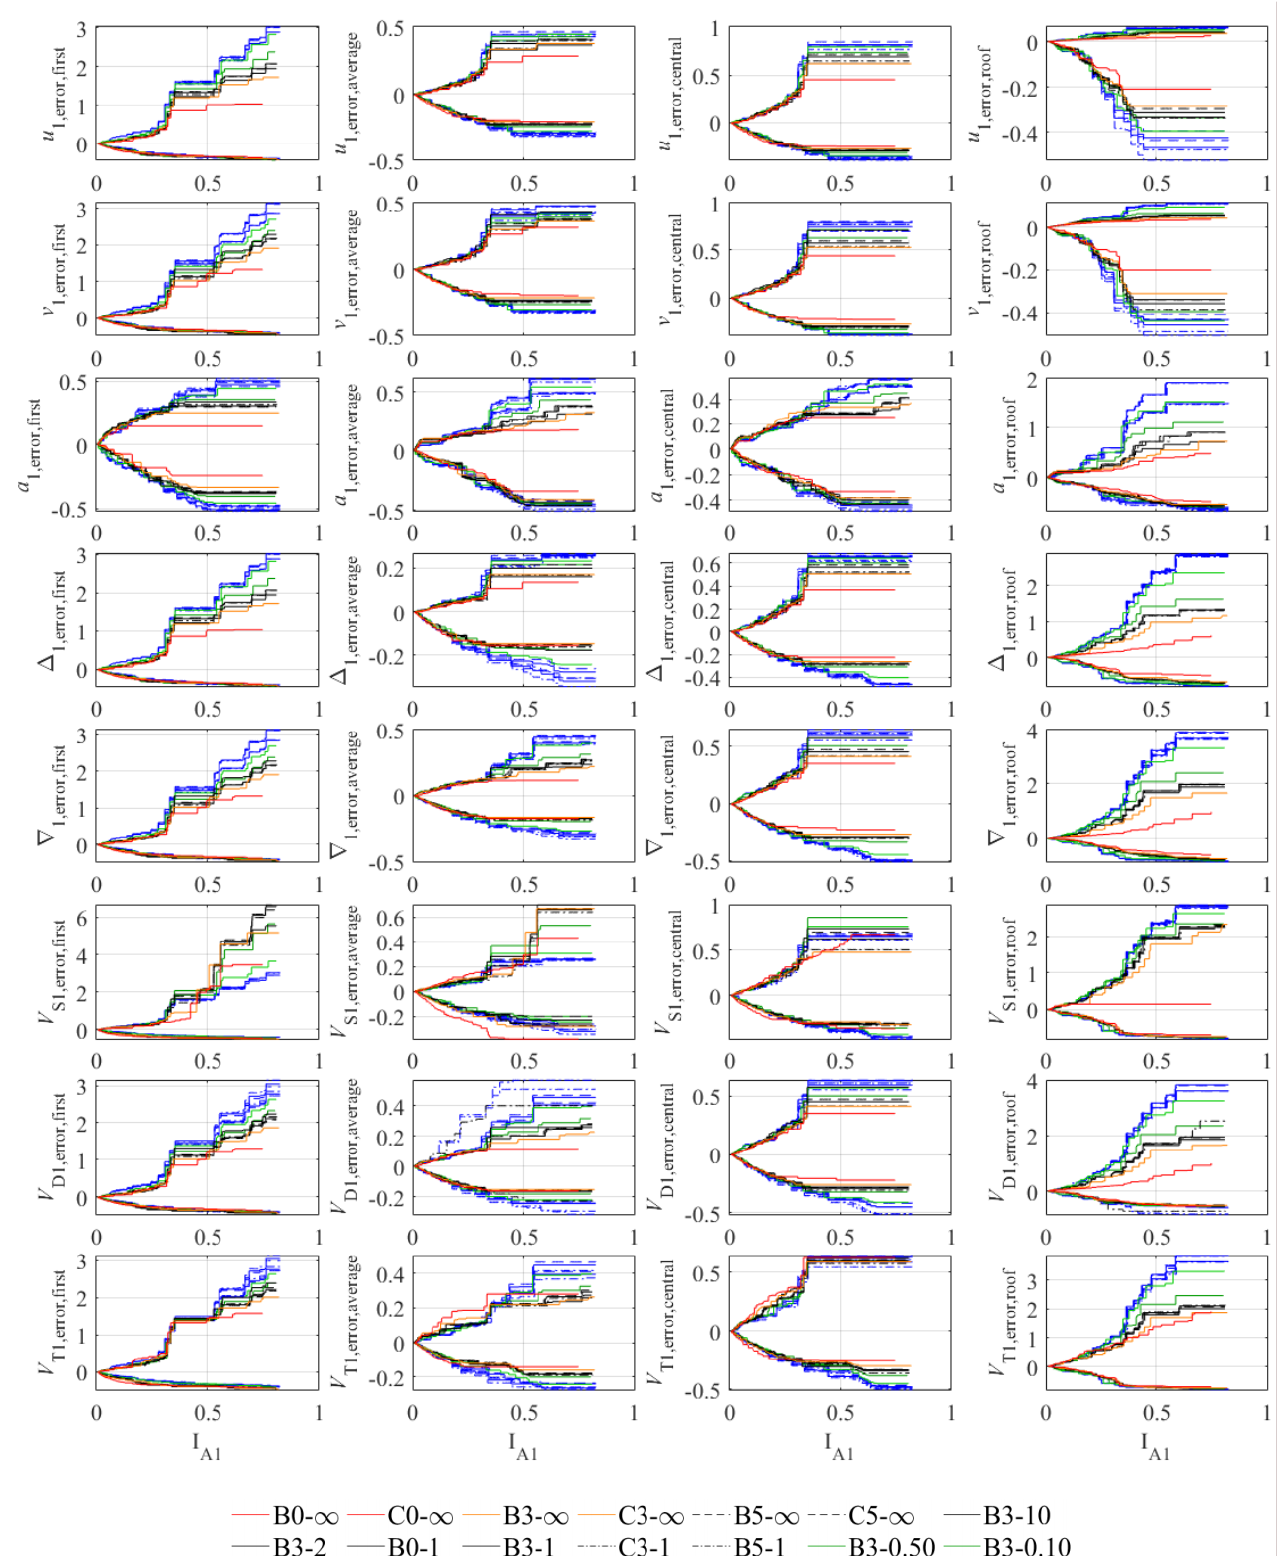
Figure 10. THMA error (type 1) max and min envelope for all cases versus index I A 1 . For unconservative errors, the curves are, in general, more closely squeezed than for conservative errors. Thus, the distinction between frame-type and shear-type system is